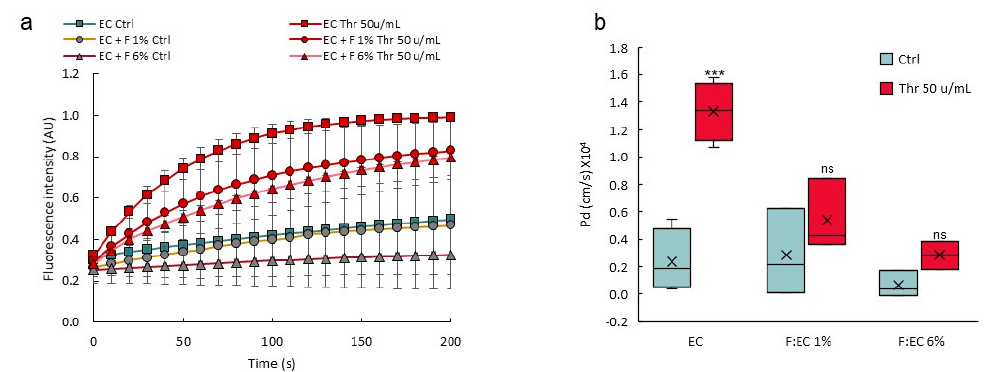
Figure 11. A higher perivascular:endothelial cell ratio tightens the vascular barrier. ( a ) Diffusion of 70 kDa dextran-FITC into the collagen layer overtime; data are extracted from video recordings; n = 3 VoC per condition; 1 point each 10 s was extracted from the real-time measurements (3 points/s). ( b ) Calculated diffusive permeability coefficients, n = 3 VoC per condition. EC—endothelial cells; F—fibroblasts; Thr—thrombin, percentages refer to the F:EC ratio at seeding time, vessels were established eight days before performing the permeability assay *** p < 0.001; ns—nonsignificant compared to Ctrl. Eighteen VoC were processed at a time in this representative